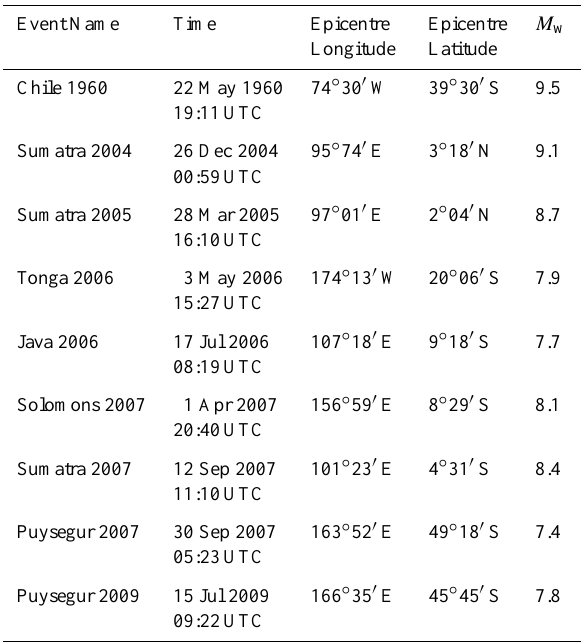
Table 1. Tsunami events used to evaluate coastal warning